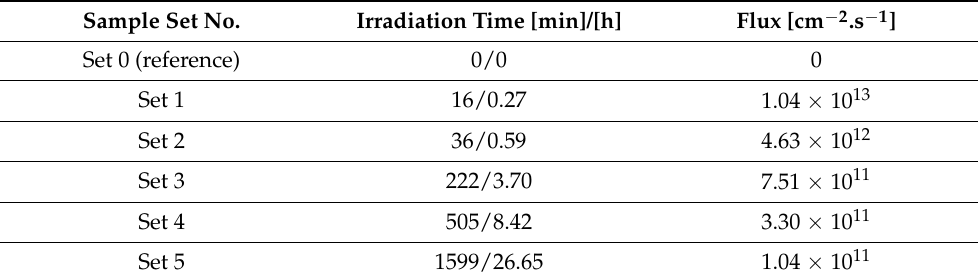
Table 2. As-prepared test samples for the irradiation experiment. Sample Set No.